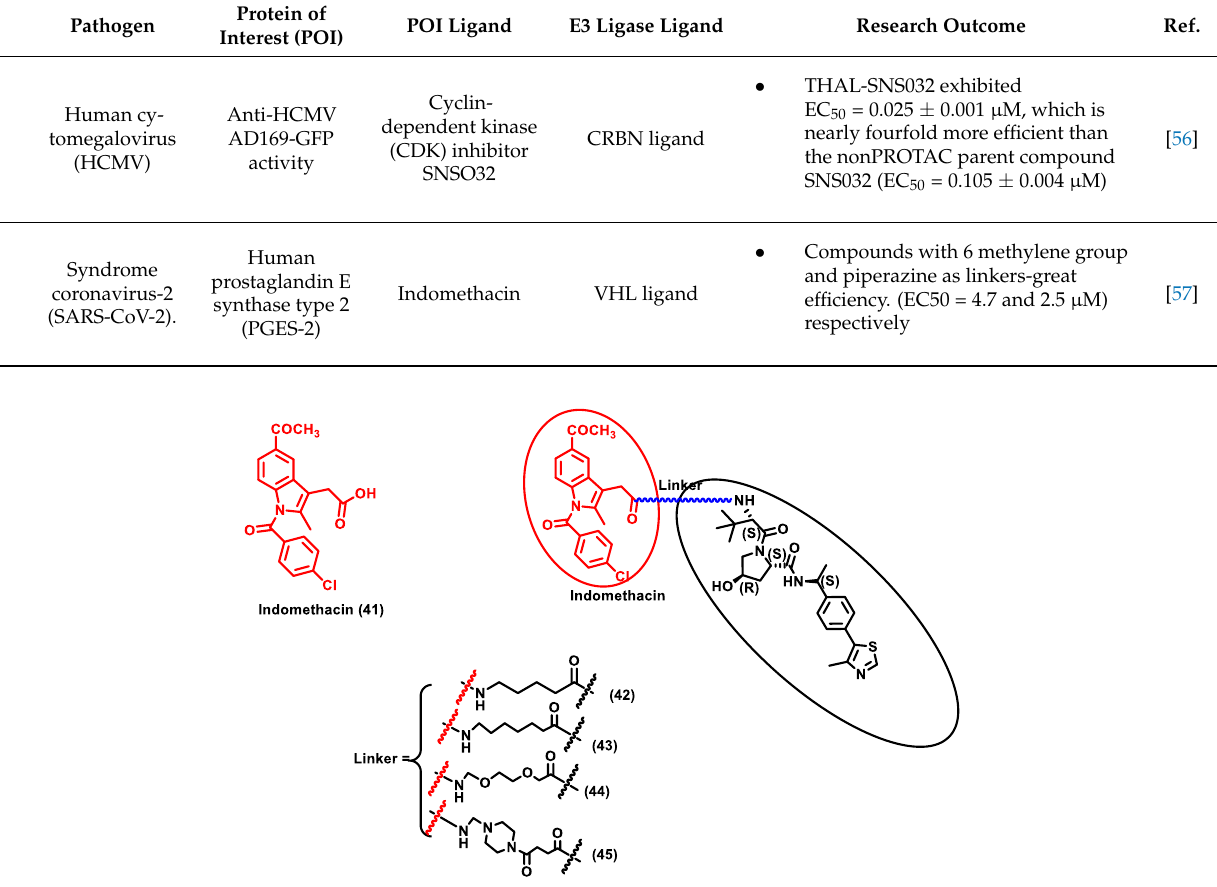
Table 3. Comprehensive information on the targeted degradation of human host protein using PROTACs.